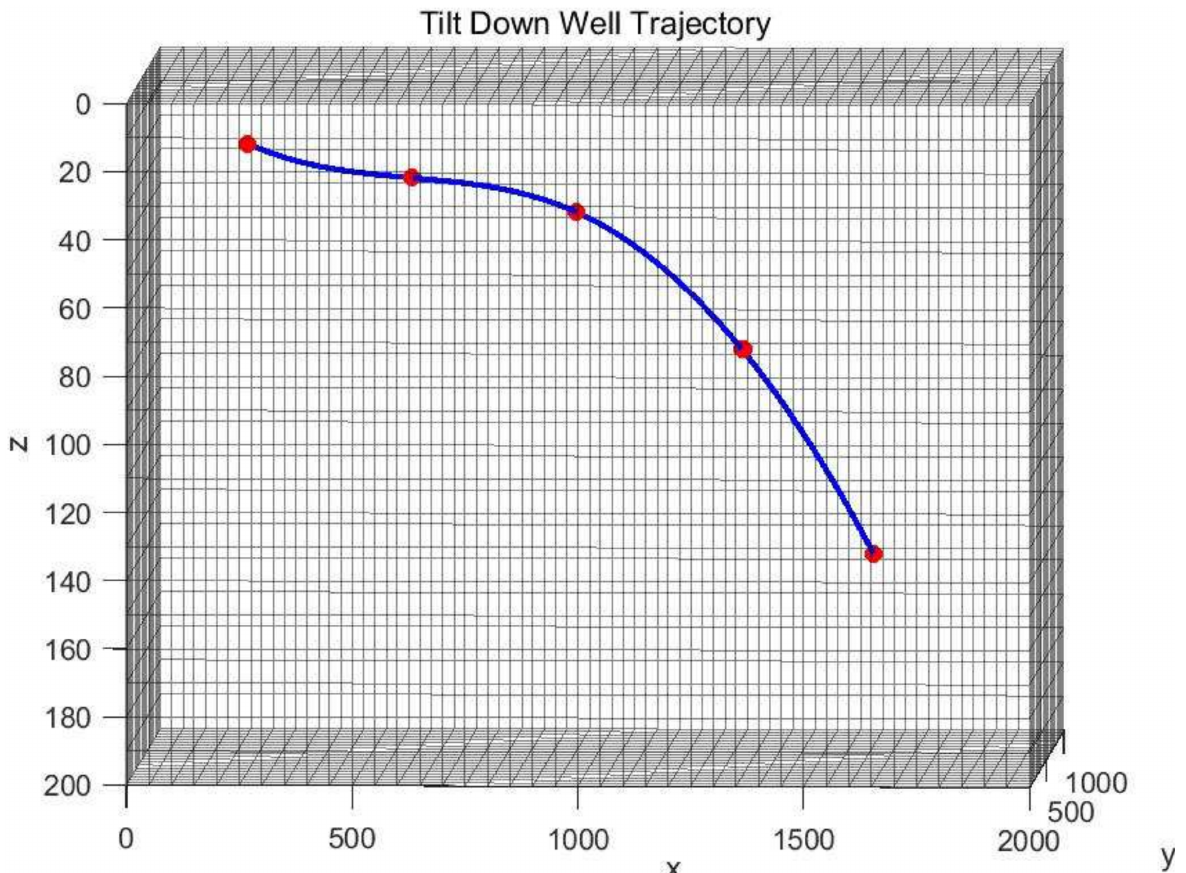
Figure 12. Tilt-down well trajectory with a depth difference of 120 m from the well’s starting point.